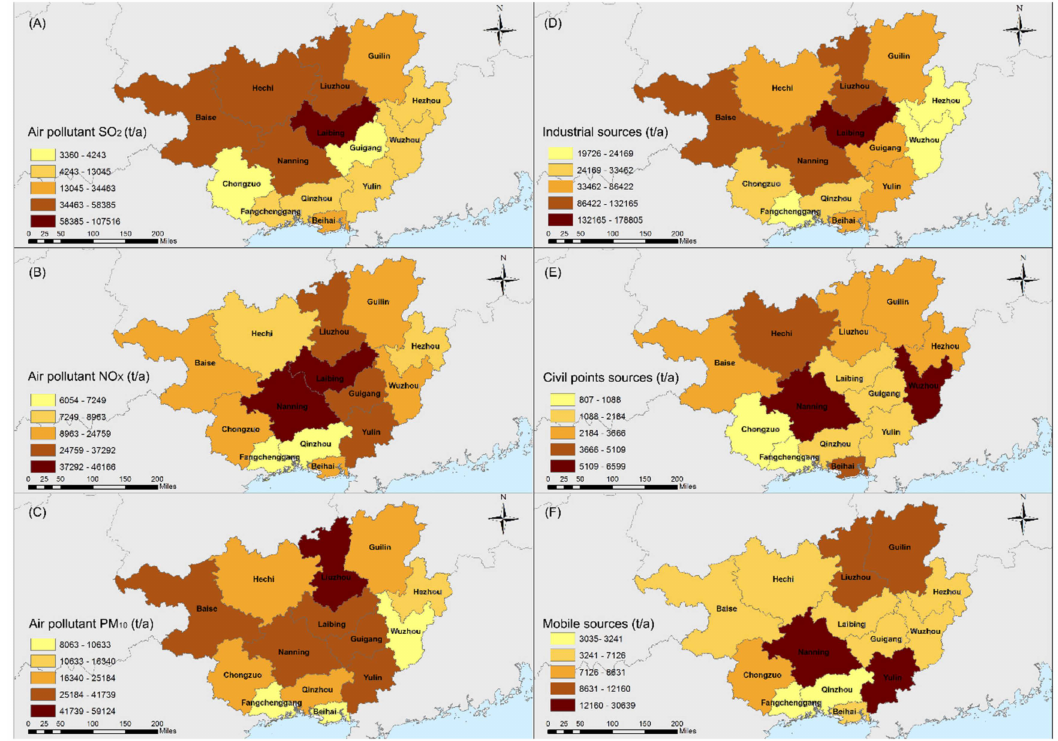
Figure 3. Major air pollutants ( A – C ) and di ff erent sources ( D – F ) in 14 cities of Guangxi